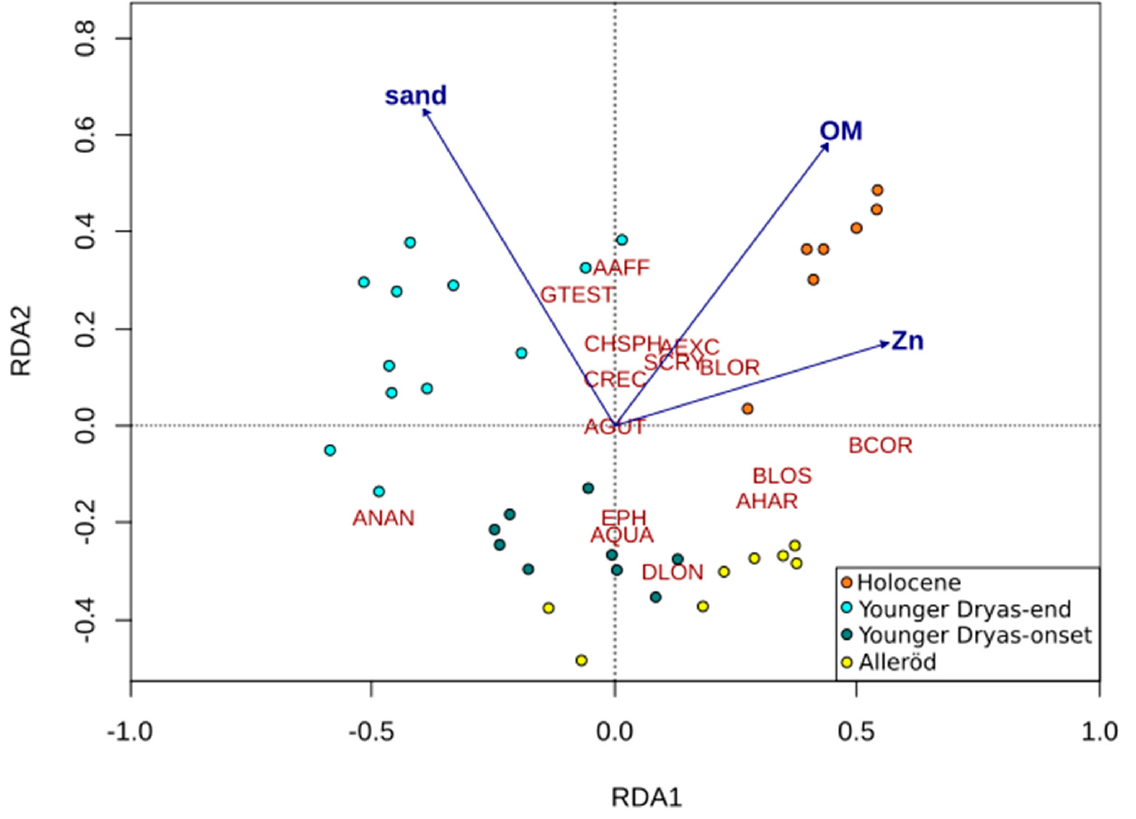
Figure 9. Redundancy analysis (RDA) biplot on forward-selected environmental variables, showing the distribution of sediment samples and key cladoceran species. RDA was performed for the Alleröd/Younger Dryas and Younger/Dryas/Holocene transitions. Black arrows indicate the scores of the environmental variable. Colored points indicate locations of sediment samples. Variable (taxon) names: DLON = Daphnia longispina group; BCOR = Bosmina ( E. ) coregoni ; BLOR = Bosmina longirostris ; BLOS = Bosmina ( E. ) longispina ; AAFF = Alona affinis ; AHAR = Acroperus harpae ; AGUT = Alona guttata ; AQUA = Alona quadrangularis ; AEXC = Alonella excisa ; ANAN = Alonella nana ; CREC = Coronatella rectangula ; CHSPH = Chydorus sphaericus ; GEST = Graptoleberis testudinaria ; SCRL = Sida crystallina ; and EPH = ephippia.